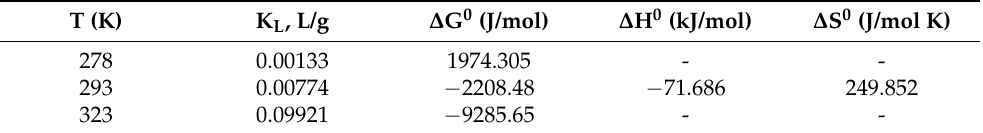
Table 3. Values of thermodynamic parameters characteristic of the biosorption process of Methylene Blue dye on OxC25 hydrogel as biosorbent.